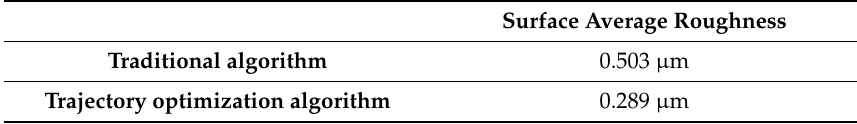
Table 4. Comparison of average surface roughness results under the di ff erent